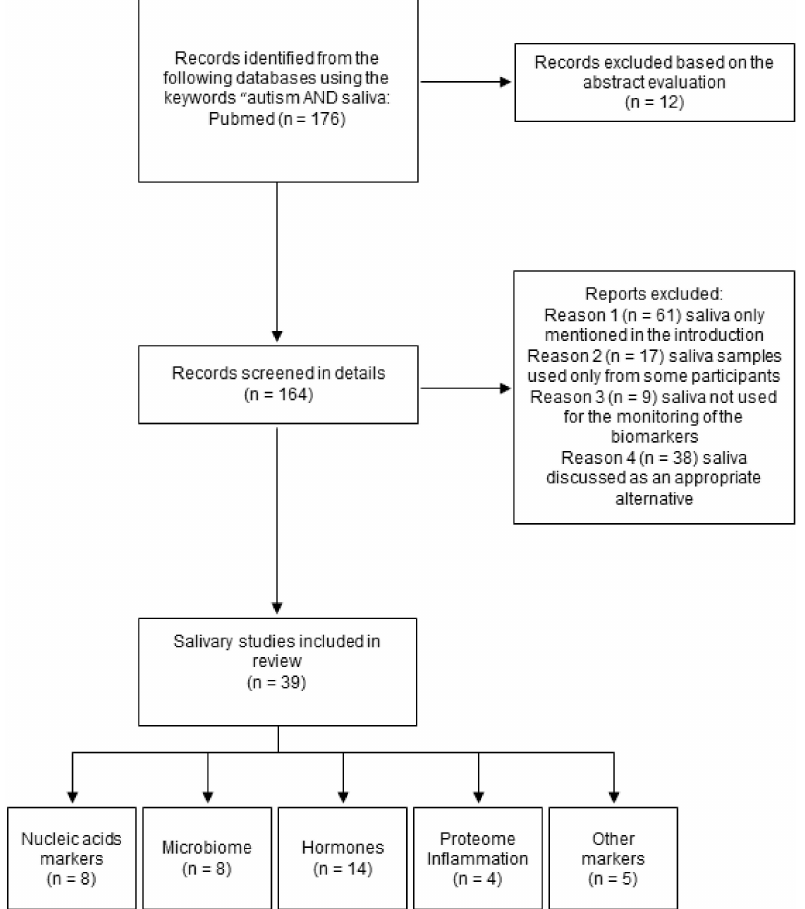
Figure 1. Flow diagram and research strategy for this